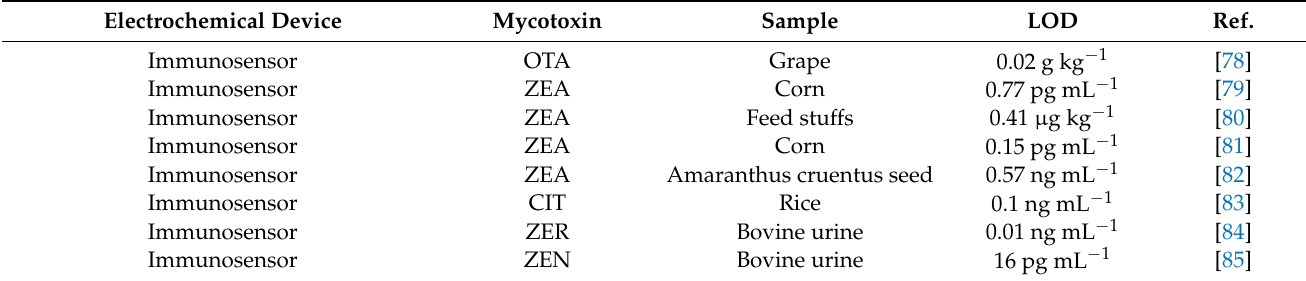
Table 5. Electrochemical immunosensors for mycotoxin detection developed in Argentina in the last 10 years. See the abbreviation list at the end of the